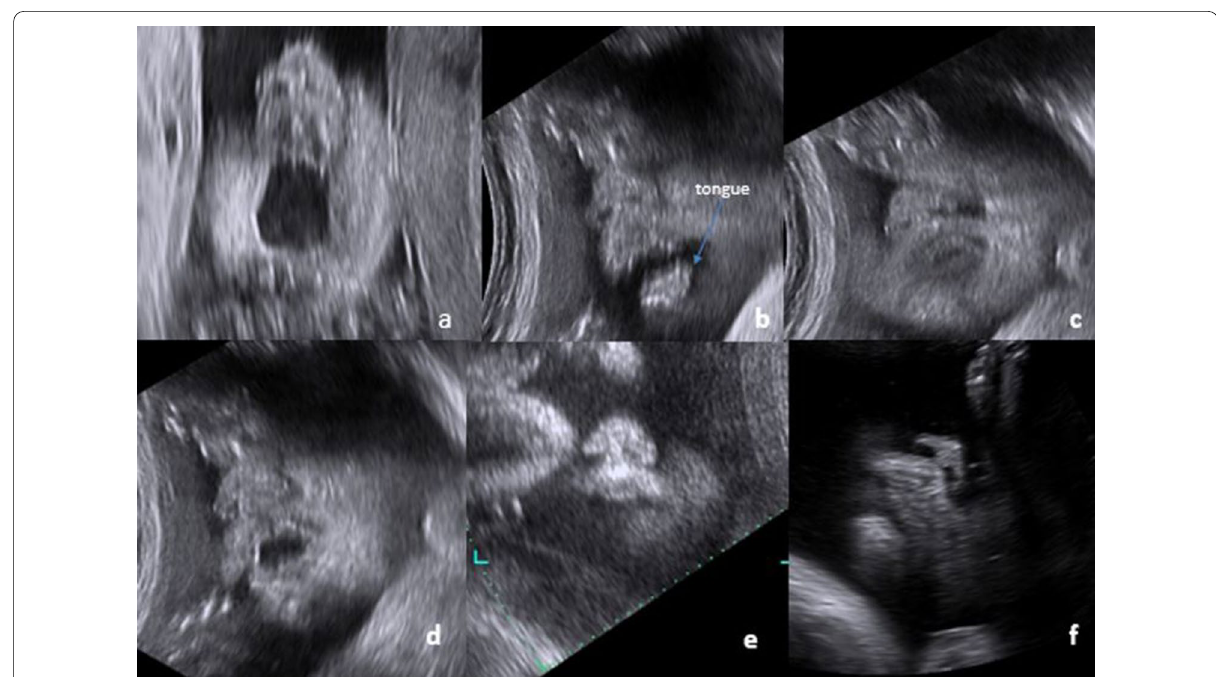
Fig. 8 Different facial expressions at different fetal age groups; yawing, tongue expulsion, scowling, mouthing, smiling, suckling; image ( a – f ), respectively